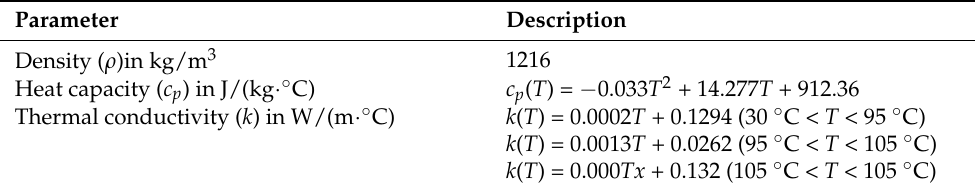
Table 3. List of parameters of PHBH used in the simulation. Parameter Description